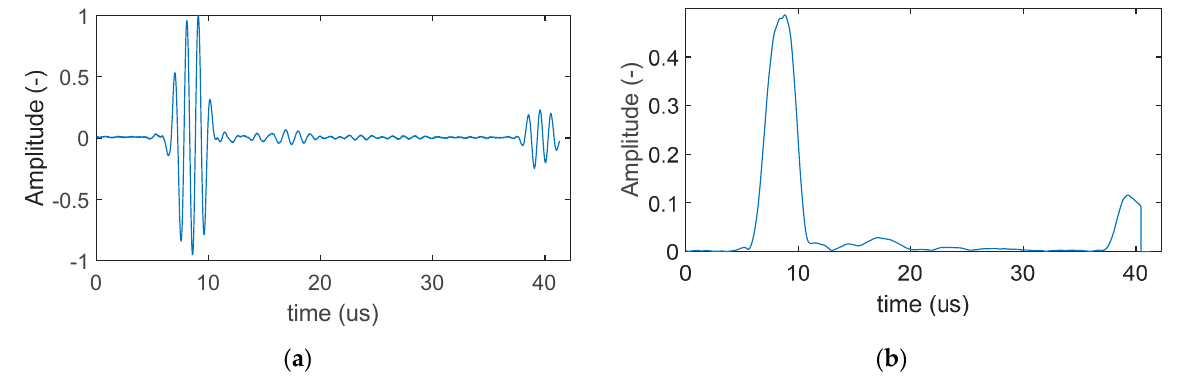
Figure 9. Echoes acquired from a metallic reflector energized by a 3-cycle burst at 1.2 MHz through the proposed transmitter.